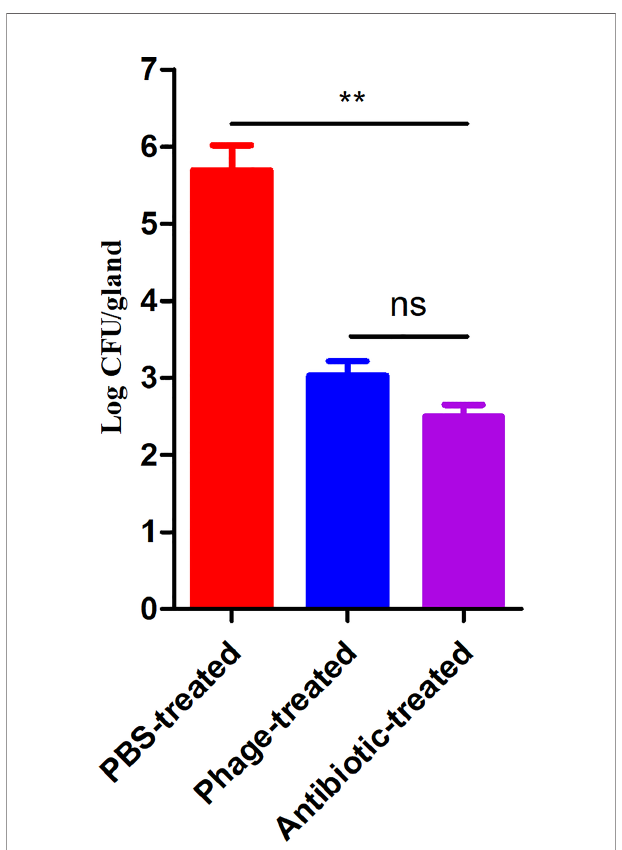
FIGURE 6 | P. aeruginosa concentrations in the mammary glands of mice treated with phage PAJD-1. The fourth abdominal mammary gland was infected with P. aeruginosa PAmas5. After 6 h, the mice were treated with the phage, an antibiotic and PBS. After 24 h, the L4 mammary glands were aseptically removed. Results are shown as means ± SEM from triplicate experiments. Signi fi cant differences ( p < 0.01) are indicated by asterisks and ns represents no signi fi